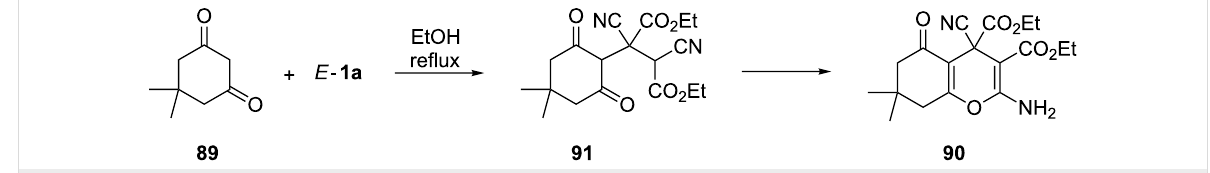
Scheme 28: Formation of diethyl 4-cyano-5-oxotetrahydro-4 H -chromene-3,4-dicarboxylate ( 90 ) from E - 1a via heterocyclization reaction.